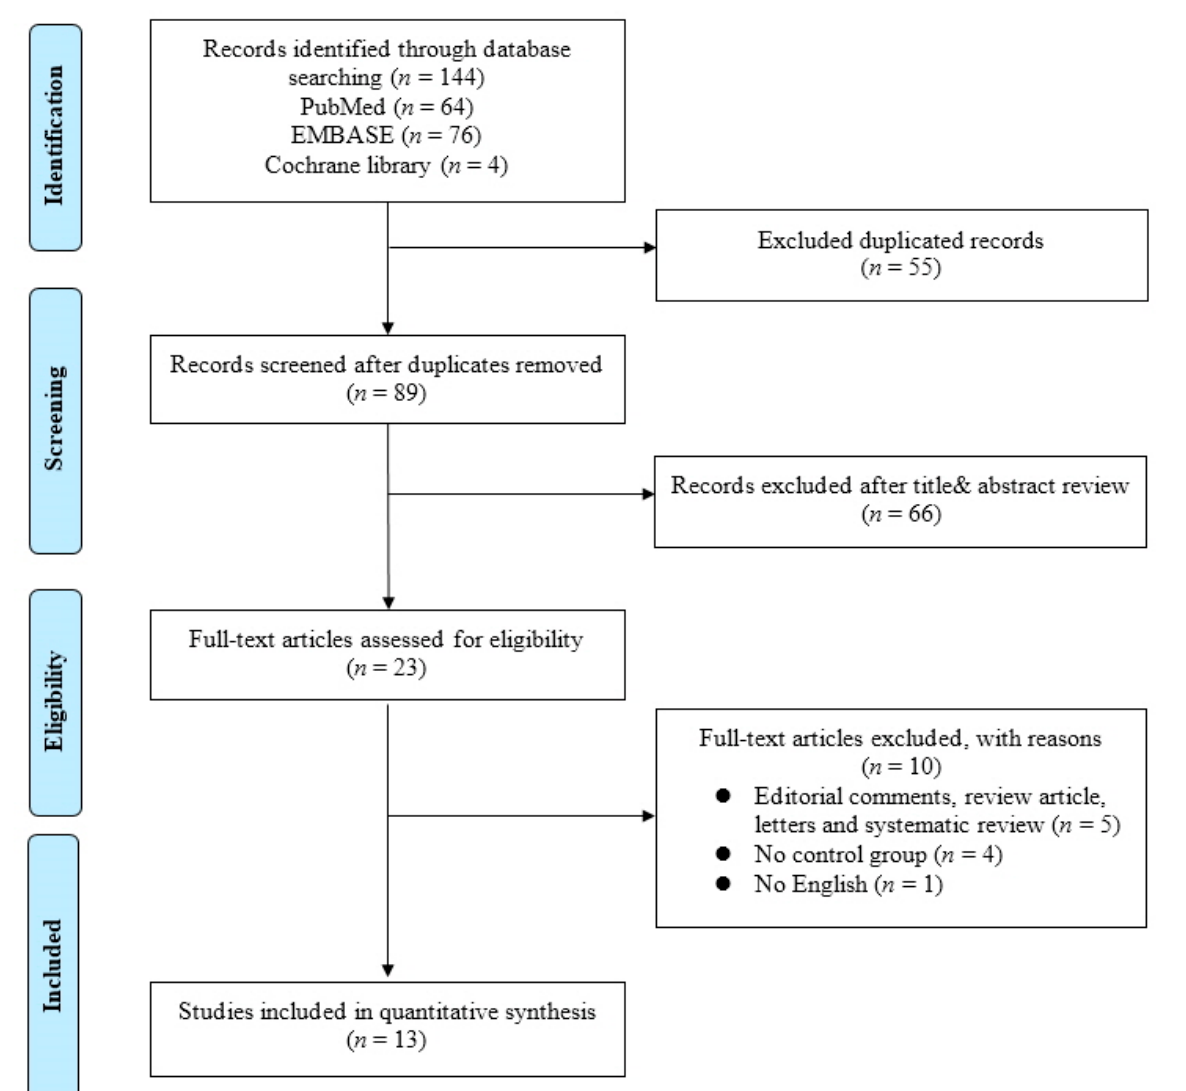
Figure 1. Flowchart of Preferred Reporting Items for Systematic Reviews and Meta-analysis (PRISMA).